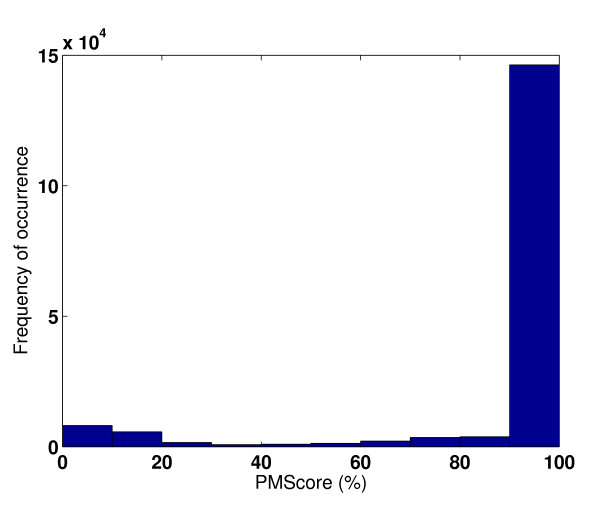
Validation with respect to tetramers. Histogram showing PMScores in the tetramer dataset.